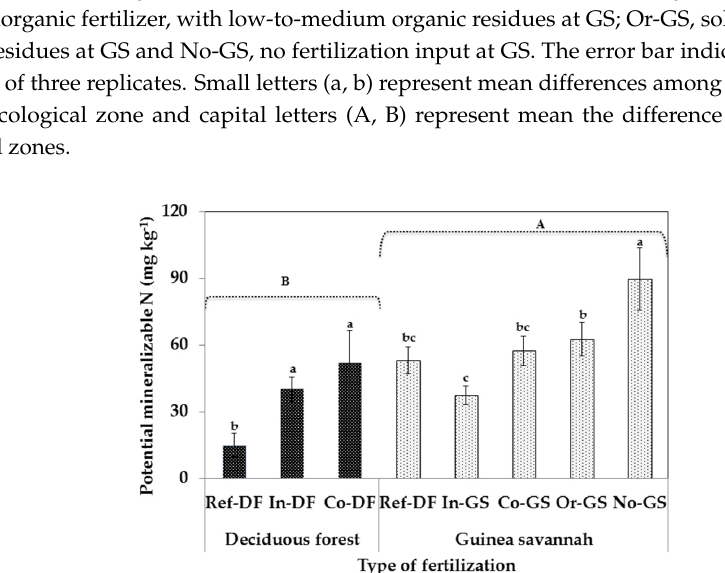
Figure 3. Potential mineralizable nitrogen at depth (0–15 cm) of different types of fertilization. Treatment code: Ref-DF, reference DF site; In-DF, inorganic fertilization at DF; Co-DF, inorganic fertilizer, with low-to-medium organic residues at DF; Ref-GS, reference site; In-GS, inorganic fertilization at GS; Co-GS, inorganic fertilizer, with low-to-medium organic residues at GS; Or-GS, sole low-to-medium organic residues at GS and No-GS, no fertilization input at GS. The error bar indicates the standard deviation of three replicates. Small letters (a, b) represent mean differences among fertilization types in each ecological zone and capital letters (A, B) represent mean the difference between the two ecological zones.